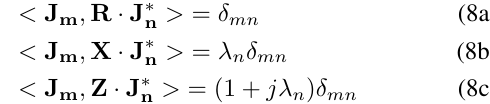
Figure 2: Jerusalem Cross element inside 15 x 15 mm square unit cell. (a) The geometry. (b) The modal significance